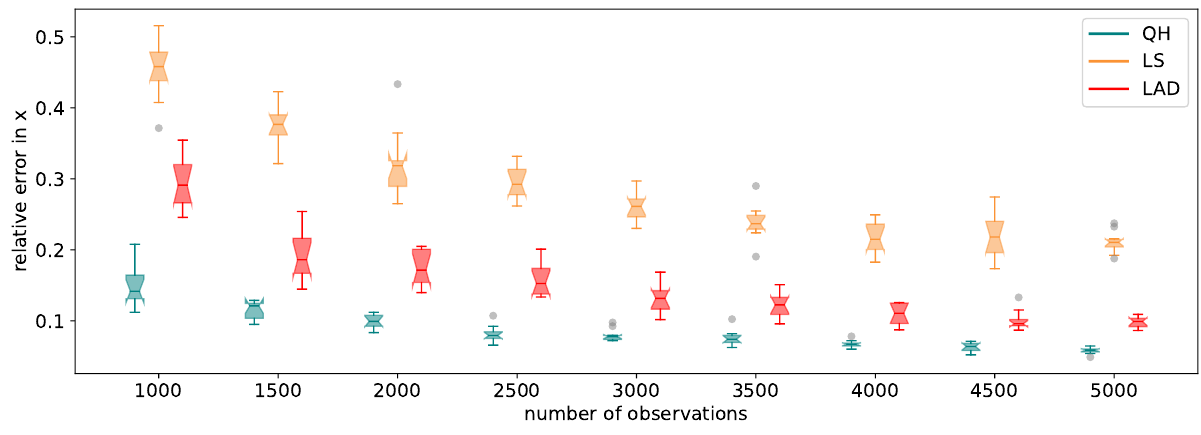
Figure 7 Relative error in recovery of regression parameters x for quantile huber (QH), least squares (LS) and least absolute deviation (LAD) approaches when measurement errors come from the quantile Huber ( τ ∗ u = 0 . 1, κ ∗ = 1 . 0). Box plots summarize results across 10 realizations of each experiment. The quality of quantile Huber result is far superior to those of both the least squares and LAD solutions across all observations. The least squares solution is particularly vulnerable to outliers, but the LAD solution is also affected by the asymmetry of